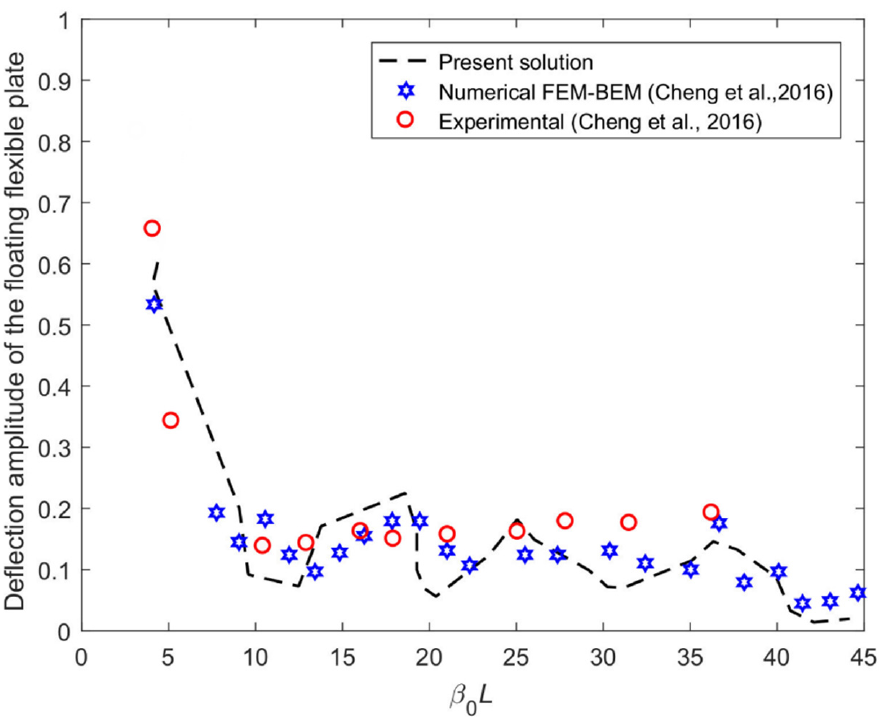
Figure 2. Comparison of the deflection amplitude with experimental datasets and FEM-BEM results for ε = 0.5 i and d / h =